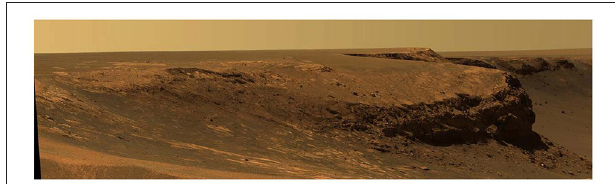
FIGURE 3 | Pancam image of Cape Verde on Victoria Crater taken by Opportunity . Image credit: